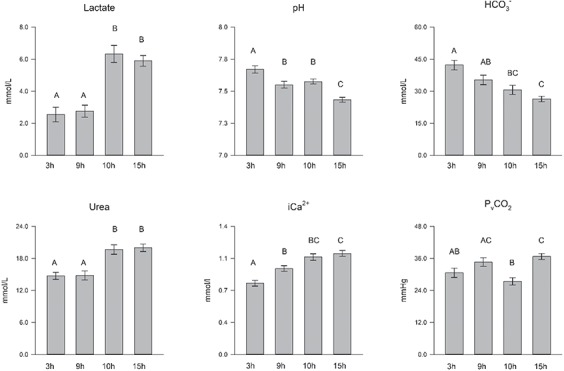
Mean and standard error for groups at 3, 9, 10 and 15 h after feeding for analytes where significant differences were detected with letters denoting pairwise differences.